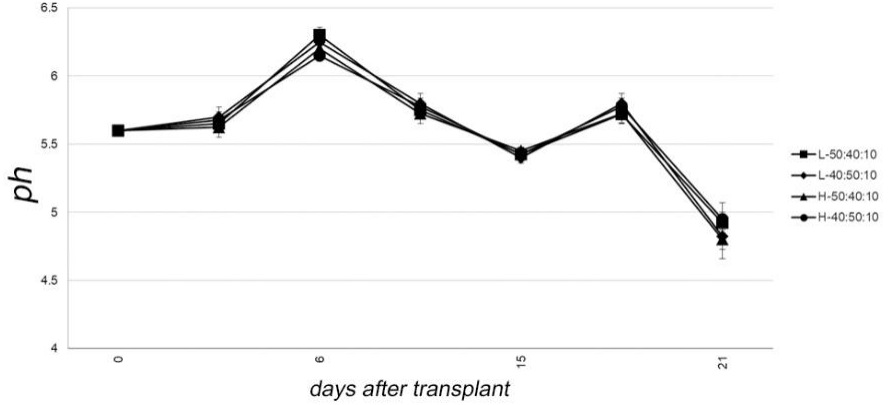
Figure 4. Mean weakly pH levels during the cultivation period. Vertical bars denote ± standard errors of means (n = 4).